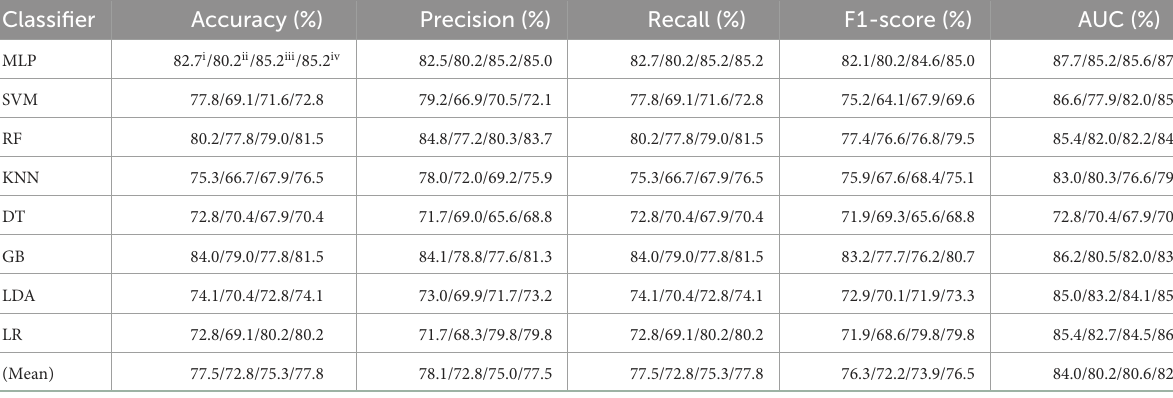
TABLE 4 Evaluation metrics of the different classifiers with four selected combination features (Experiment 2) on the test set.